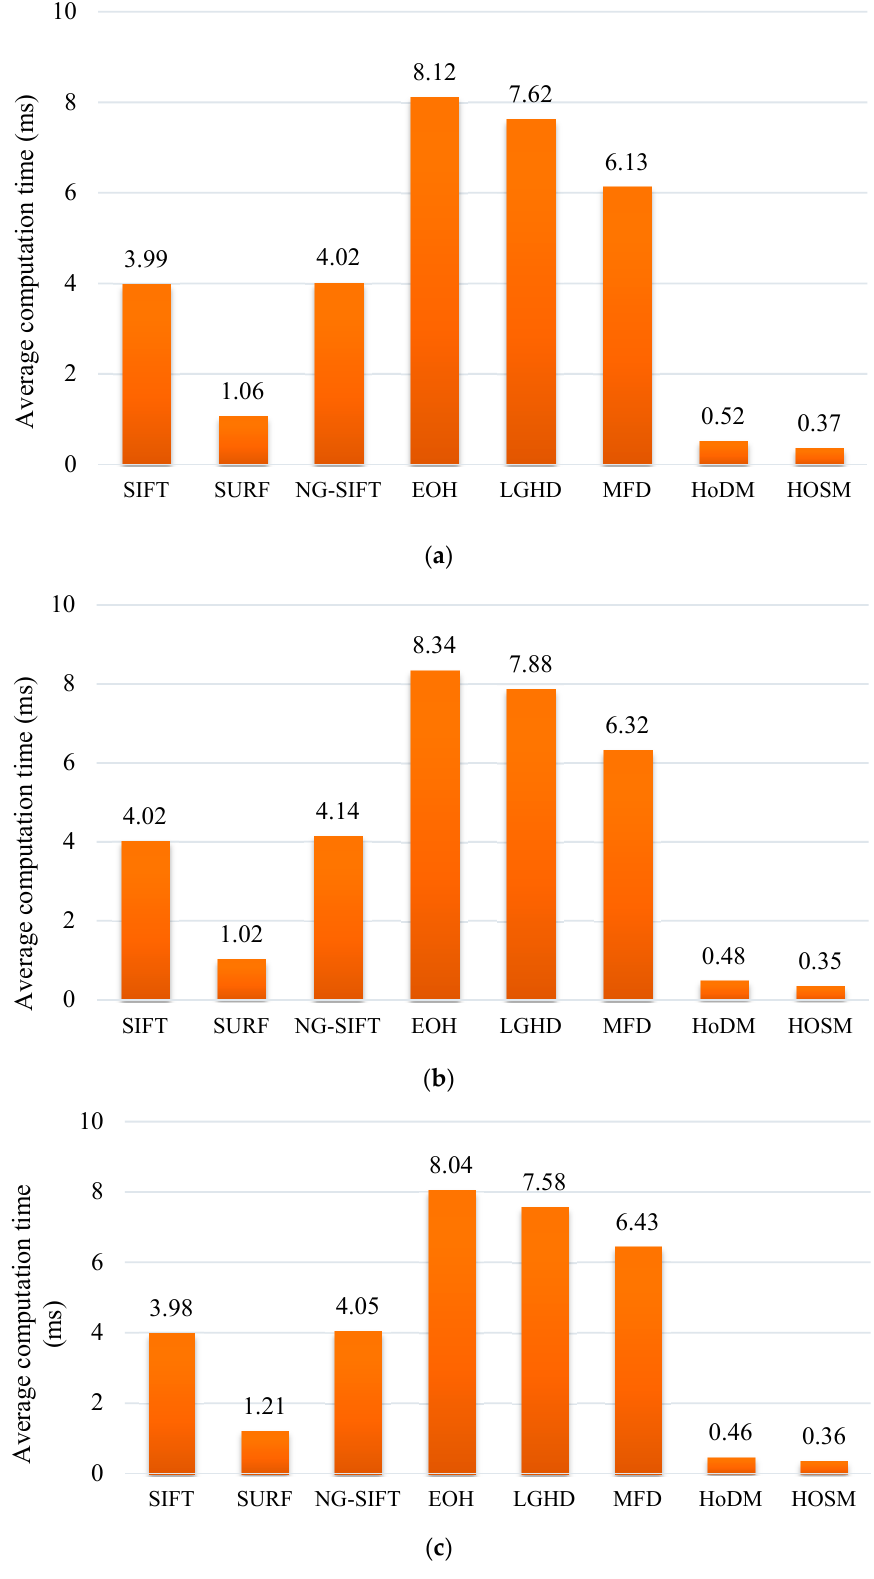
Figure 13. Quantitative comparisons on average computation time for all the descrtiptors. ( a ) Potsdam dataset, ( b ) EPFL dataset, and ( c ) CVC dataset.